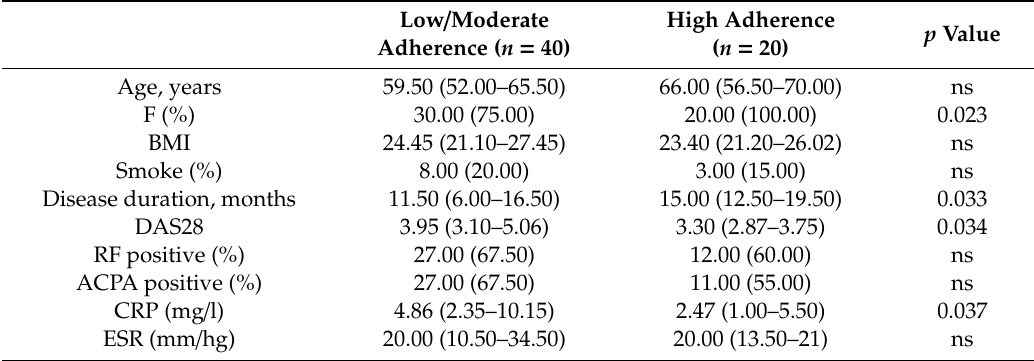
Table 2. Main demographic, anthropometric, and clinical characteristics of the patients, according to the adherence to Mediterranean diet.